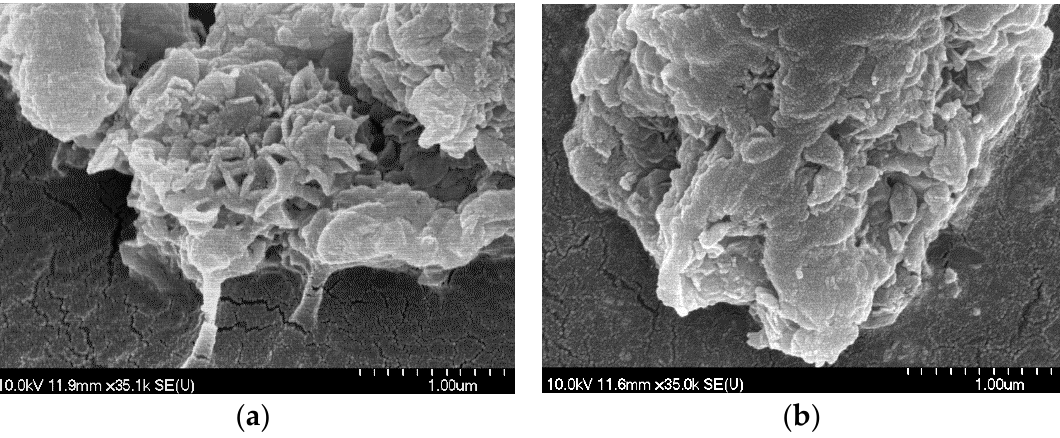
Figure 2. SEM photos of CuAl 4 –LDHs with nitrate ( a ) and perchlorate ( b ) interlayer anions.